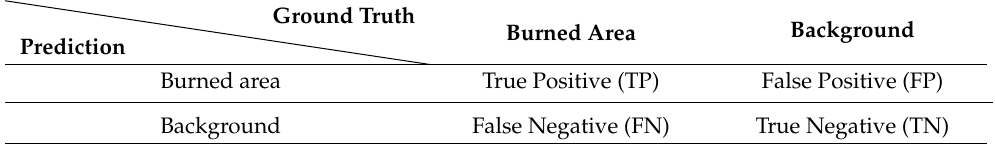
Table 5. Confusion matrix of ground truth and